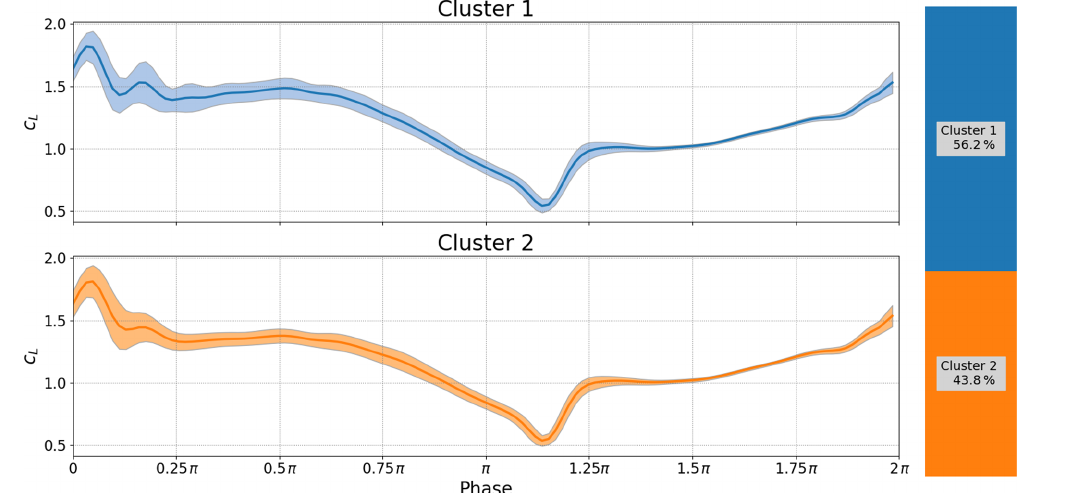
Figure 16. Deep stall investigations: cluster analysis for boundary conditions: k = 0 . 0574, Re = 5 . 7 × 10 5 and α 0 = 21 . 25 ◦ , α amp = 8 . 25 ◦